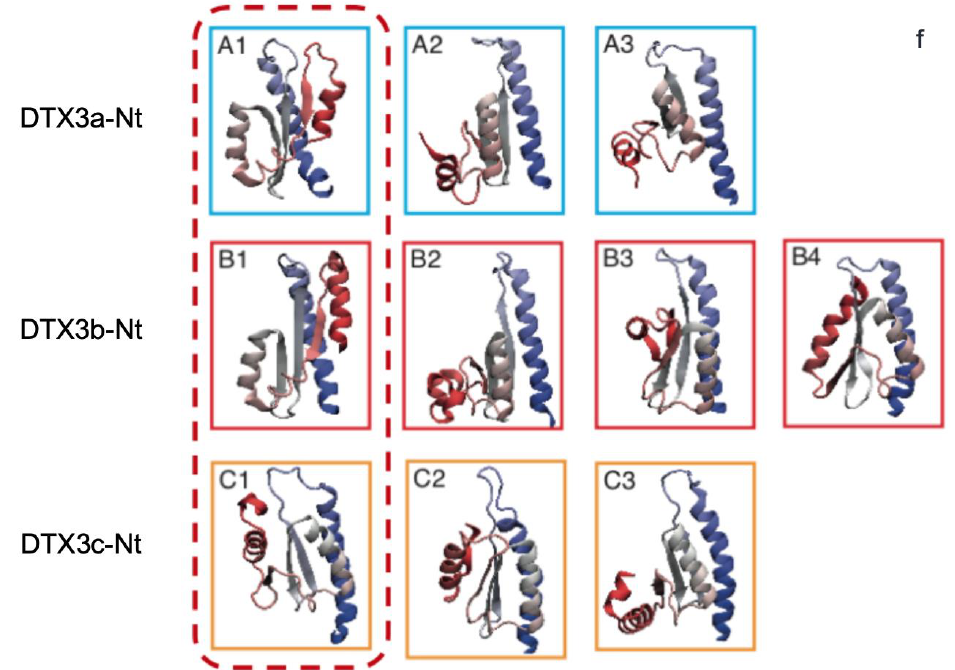
Figure 7. Tridimensional modeling of DTX3c N-terminal domain and comparison with previously identified Isoforms. ( a ) Disorder prediction graph of DTX3c N-terminal region; ( b ) cluster represen- tation for probable conformations and atomic distance of the models generated for the DTX3c N-T region; ( c ) N-Terminal domain rendering for DTX3a; ( d ) DTX3b; ( e ) DTX3c; ( f ) (A1 − C3) additional spatial distribution renderings of the three N-terminal domains of DTX3, with (A1 − A3) and (B1 − B4) displaying close 3D resemblance compared to DTX3c (C1−C3). The results suggest that DTX3c has a unique spatial distribution, implying different biological activities such as EphB4 degradation ef- ficiency. For explanation of red dotted circles, see text.